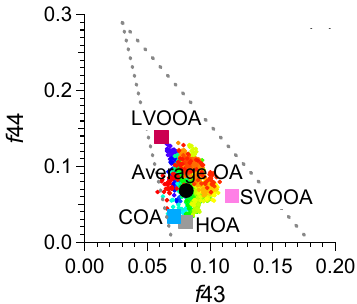
Figure 8. Triangle plot of f 44 vs. f 43 for all OA (colored by time), and the four OA factors identified by the PMF